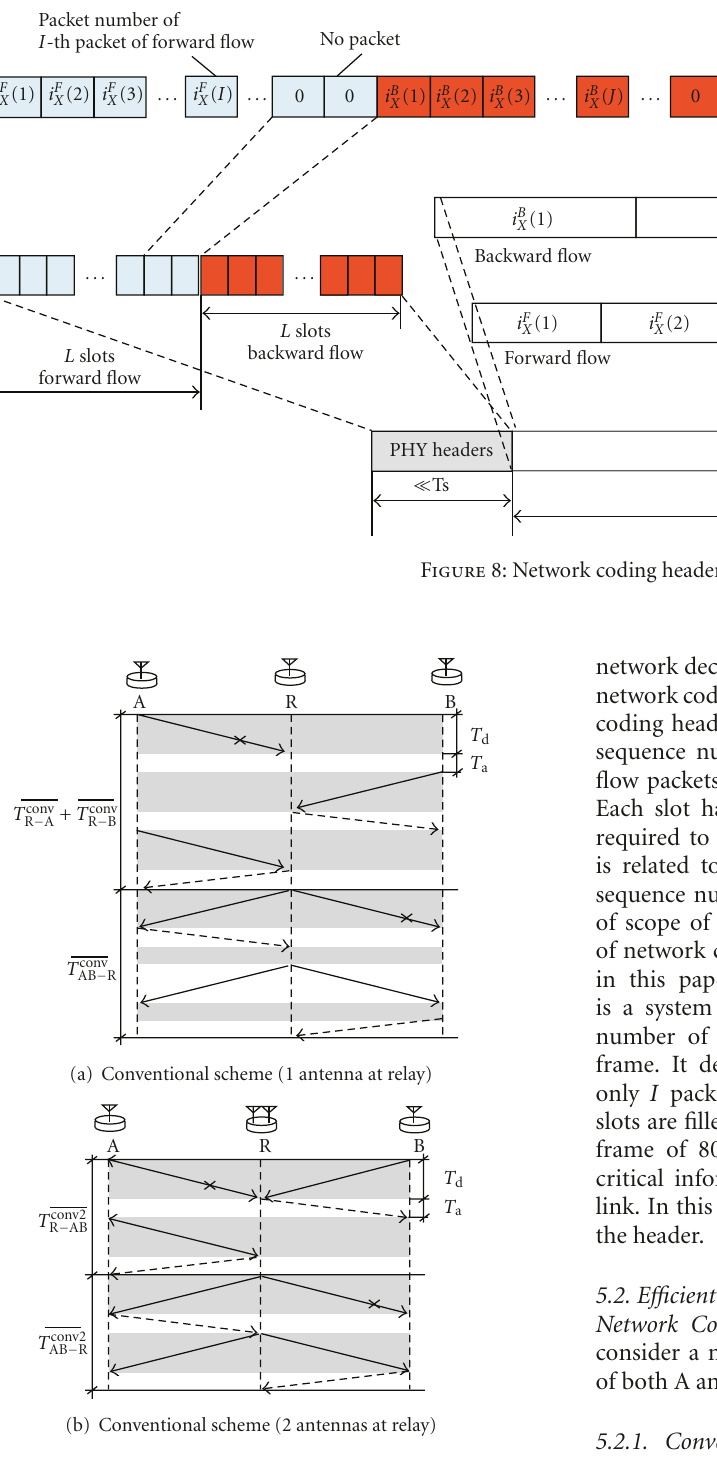
Figure 9: Conventional retransmission